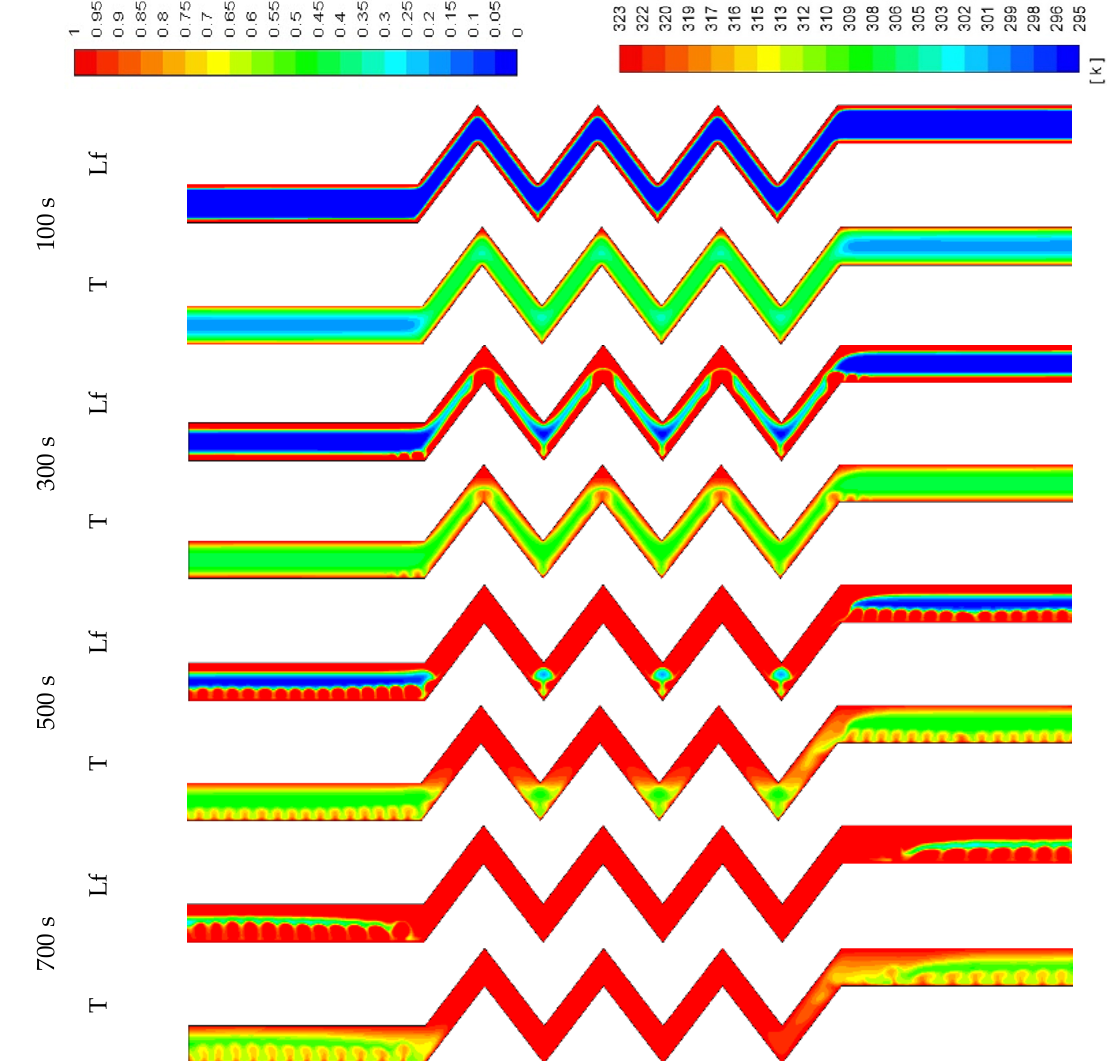
Figure 18. Contours of the liquid-fraction and temperature in a melting process for the double width (2 W) horizontal corrugated channel.